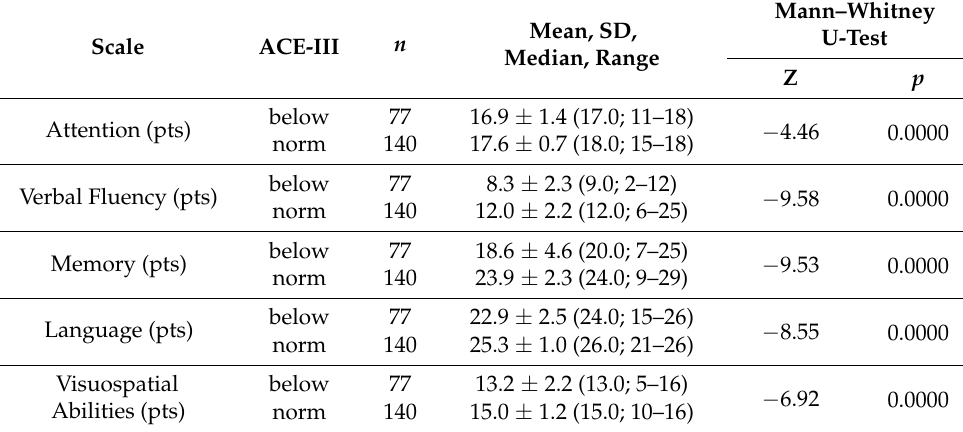
Table 2. Detailed profile of the five sub-domains of the study participants who scored below and within the norm in ACE-III as well as Mann–Whitney U-Test results (only people who scored within the norm in